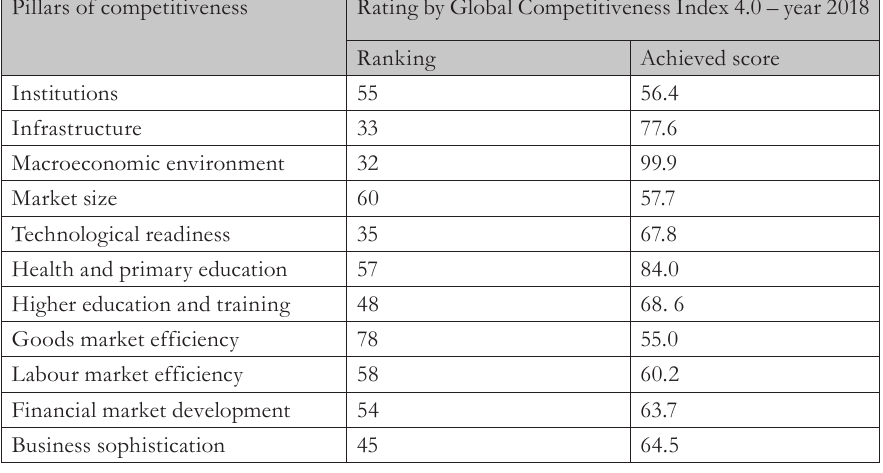
Tab. 2 – Competitiveness of the Slovak Republic in 2018. Source: The Global Competitiveness Report